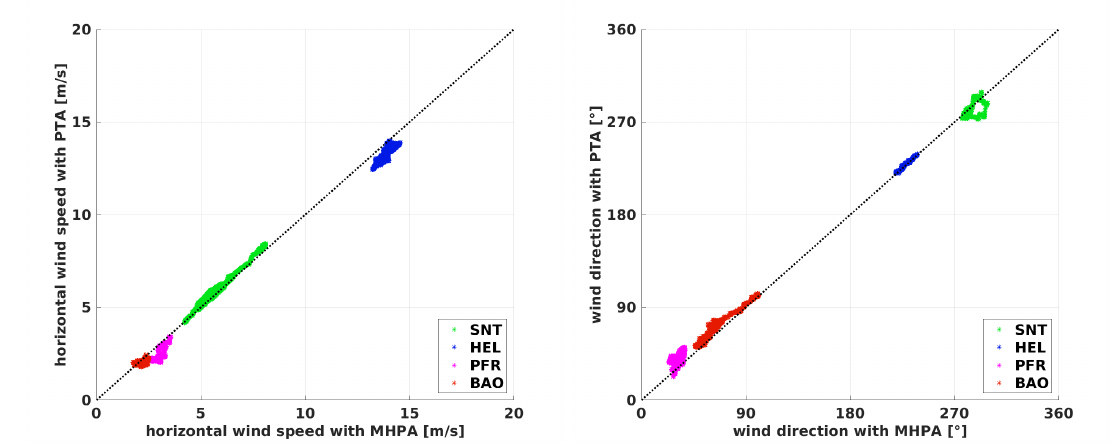
Figure 11. Comparison of the horizontal wind speed ( left ) and the wind direction ( right ) on a window of 4 min for the flights at the Boulder Atmospheric Observatory (BAO), Schnittlingen (SNT), Helgoland (HEL), and Pforzheim (PFR). The black dashed line shows the bisecting line where the multi-hole-probe algorithm (MHPA) equals the pitot tube algorithm (PTA). The data is calculated on a window with M = 240 s . The results from the MHPA are plotted against the results from the PTA